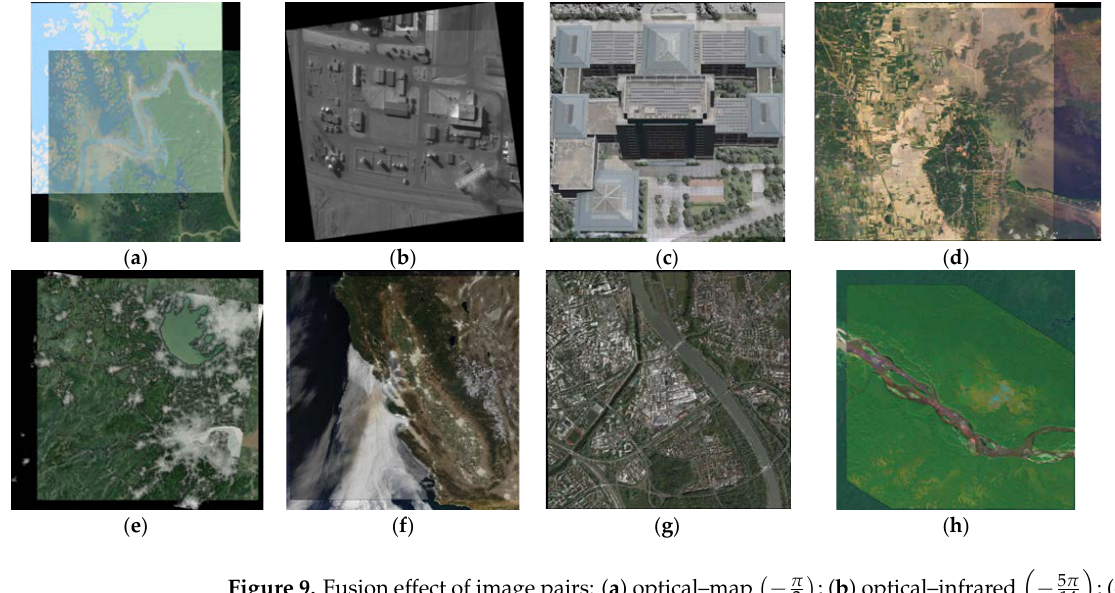
Figure 9. Fusion effect of image pairs: ( a ) optical–map (cid:16) (cid:17) − 3 π depth ; ( d ) optical–optical 14 (cid:16) (cid:17) 5 π ; and ( h ) optical–SAR 14